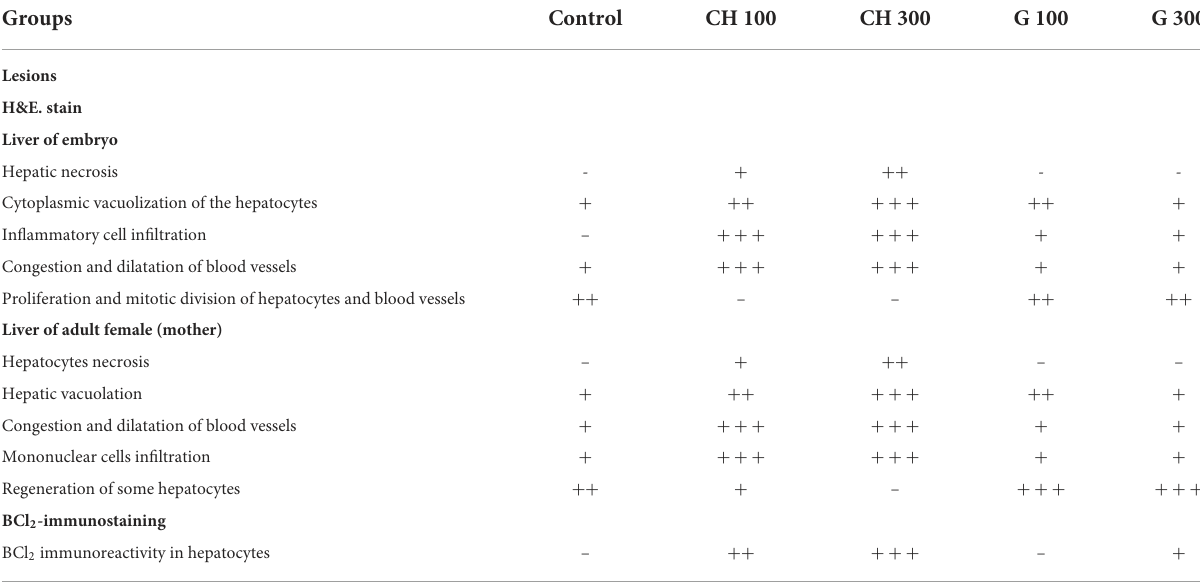
TABLE 5 Histopathological and immunostaining scores from the liver of the embryo and mother of control and other experimental groups. Groups Control CH 100 CH 300 G 100 G 300 Lesions